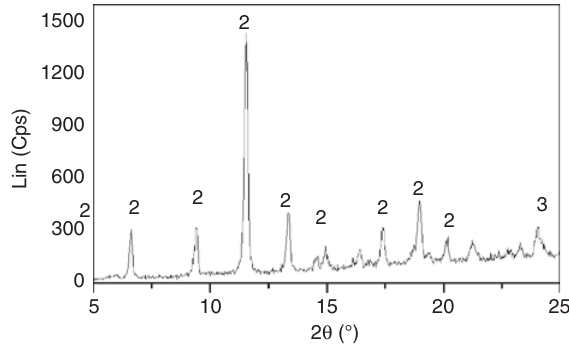
Figure 3: X-ray diffraction pattern of Cu-BTC, formed from Cu and